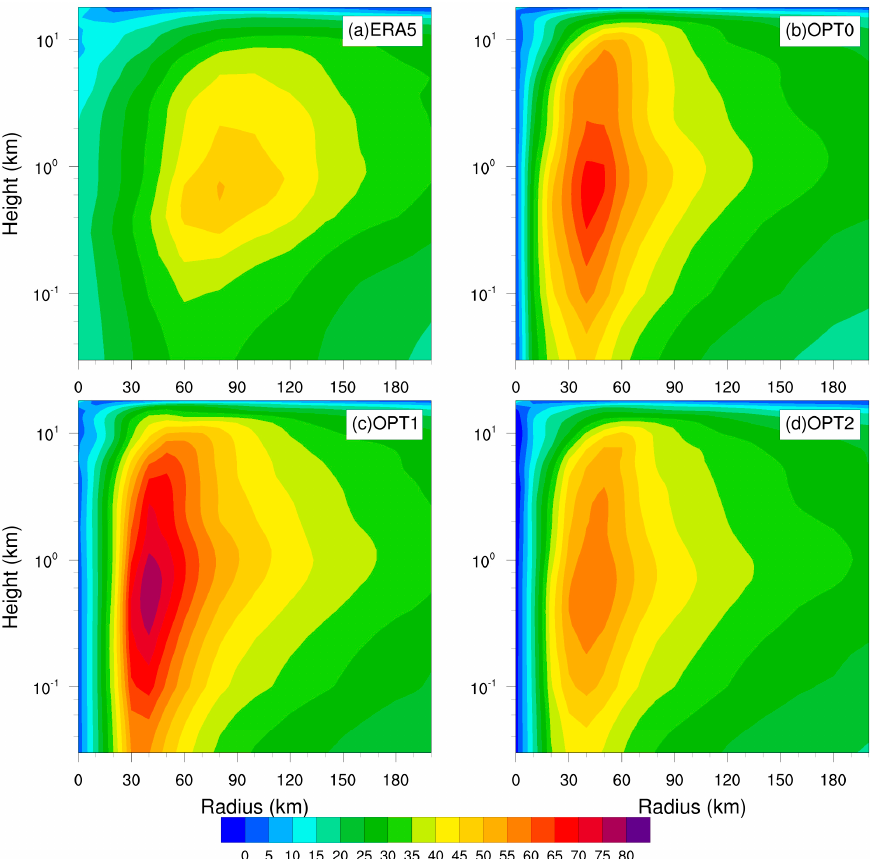
Figure 8. Height–radius distribution of azimuthally averaged tangential wind (unit: m s − 1 ) from ( a ) ERA5, ( b ) OPT0, ( c ) OPT1, and ( d ) OPT2 at 1200 UTC 12 September 2018. Radius–height plots of the tangential, radial, and vertical winds at 1200 UTC 12 Sep- tember (Figures 8–10) indicate that the different air–sea flux schemes yield the same gen- eral wind structure, which is consistent with results in Green and Zhang [4], albeit with some differences in the magnitude of peak wind speed.